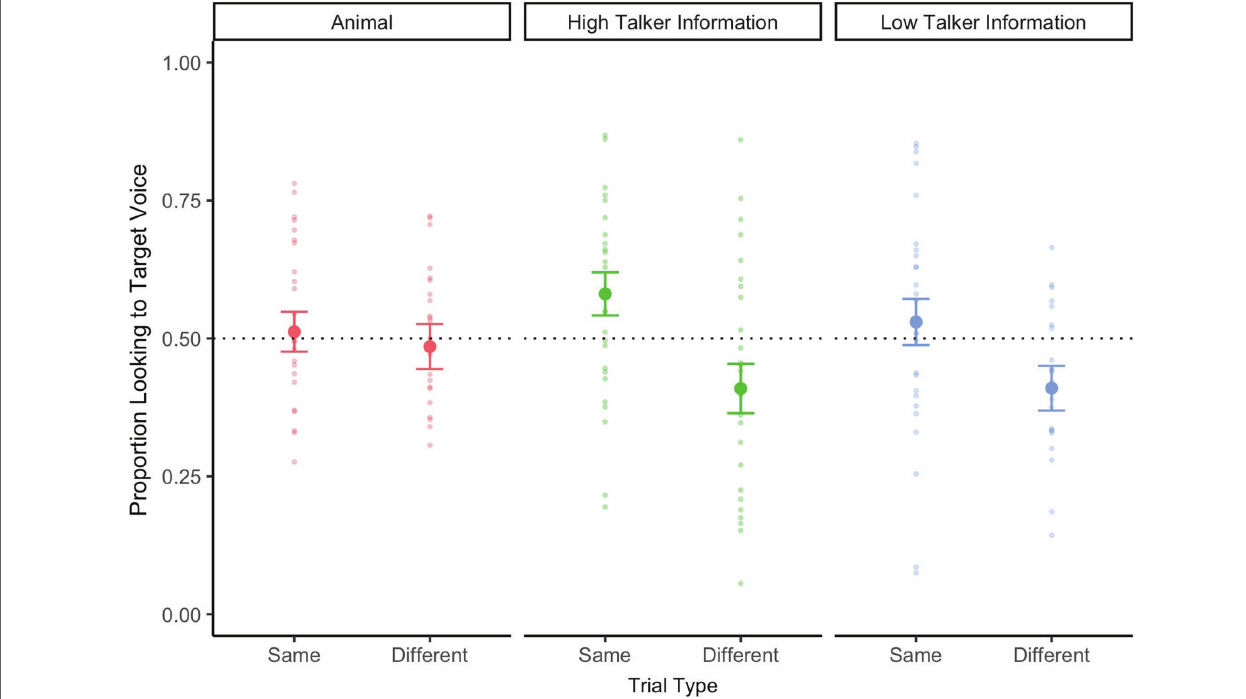
FIGURE 2 | Twelve-month-old infants’ looking data during the critical WoA in the test phase, separated by trial type ( same speaker vs. different speaker ) and talker information (high talker vs. low talker). The looking data for animal trials are also represented on this graph. A value above 0.5 represents proportionally longer looking time to the target voice. The dotted line at 0.5 refers to equal proportion looking to both faces on the screen. Errors bars represent standard